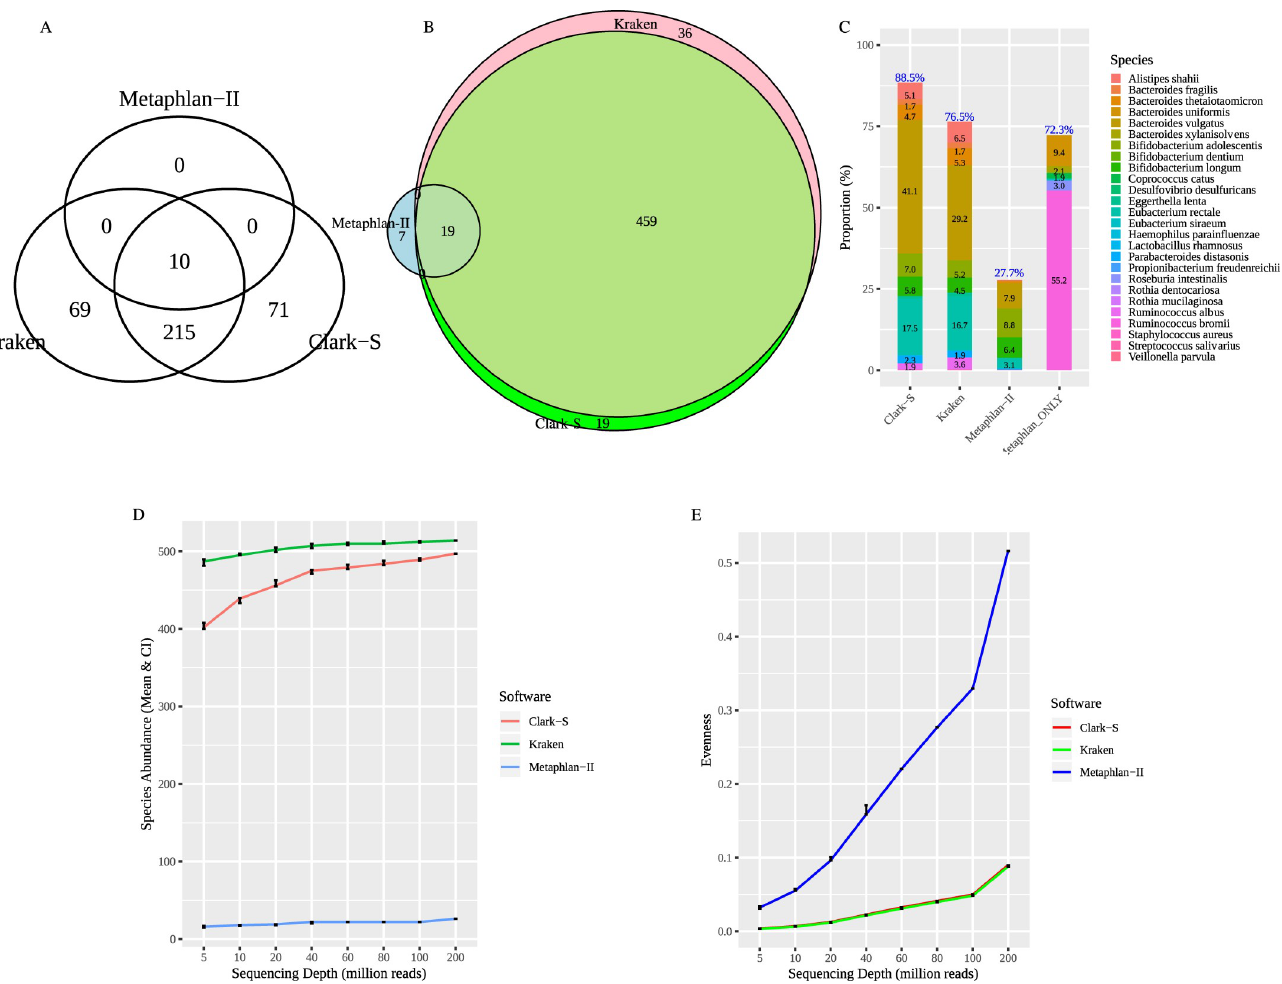
Fig 6. Taxonomical analysis using the consensus database. A Representation of predicted species abundance using Metaphlan-II, Clark-S, and Kraken, based on mock community data. B Predicted species abundance representation using full depth of fecal sample (200 million read pairs). C Composition of the 19 predicted species common to all methods, and specific for Metaphlan-II. The bar named Metaphlan_ONLY represents the species predicted by Metaphlan-II alone, whereas the other three bars represent the common species predicted by each method and their respective proportion. Species with abundance proportion below 1% are not shown in the figure. The sum of abundance proportion for each method is shown at the top of each bar. D Species richness for different taxonomy classification approaches at different sequencing depths. Species richness is shown as mean values and 95% confidence intervals (shown as error bars). E Species evenness for different taxonomy classification approaches as dependent on different sequencing depths (error bars depict 95% confidence